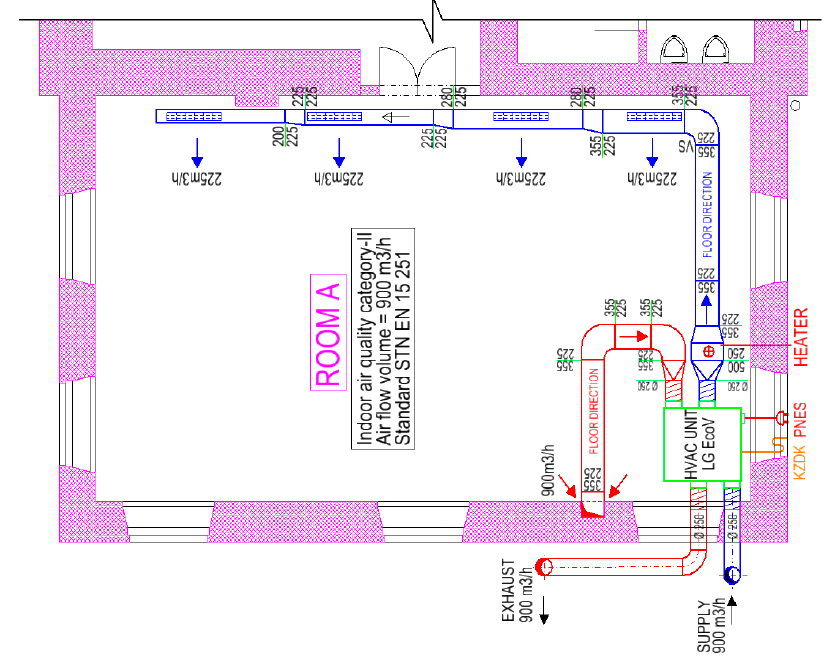
Figure 3. Floor plan of the investigated classroom with quantities of supplied and exhausted air.